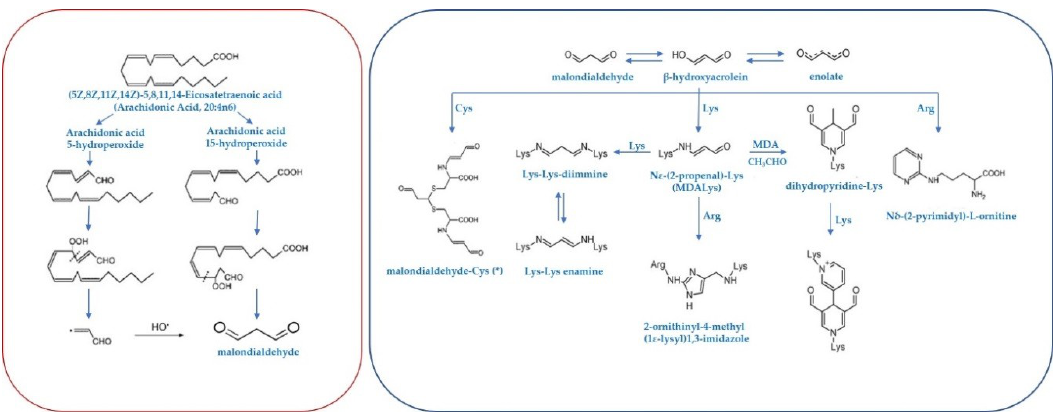
Figure 2. Mechanism of malondialdehyde formation from the polyunsaturated fatty acid arachidonic acid under oxidative conditions (modified with permission from [25]), and reaction mechanisms of formation of MDA-protein adducts and cross-links (modified with permission from [26]). Abbreviations: Arg, arginine; Cys, cysteine; Lys, lysine; MDA, malondialdehyde.